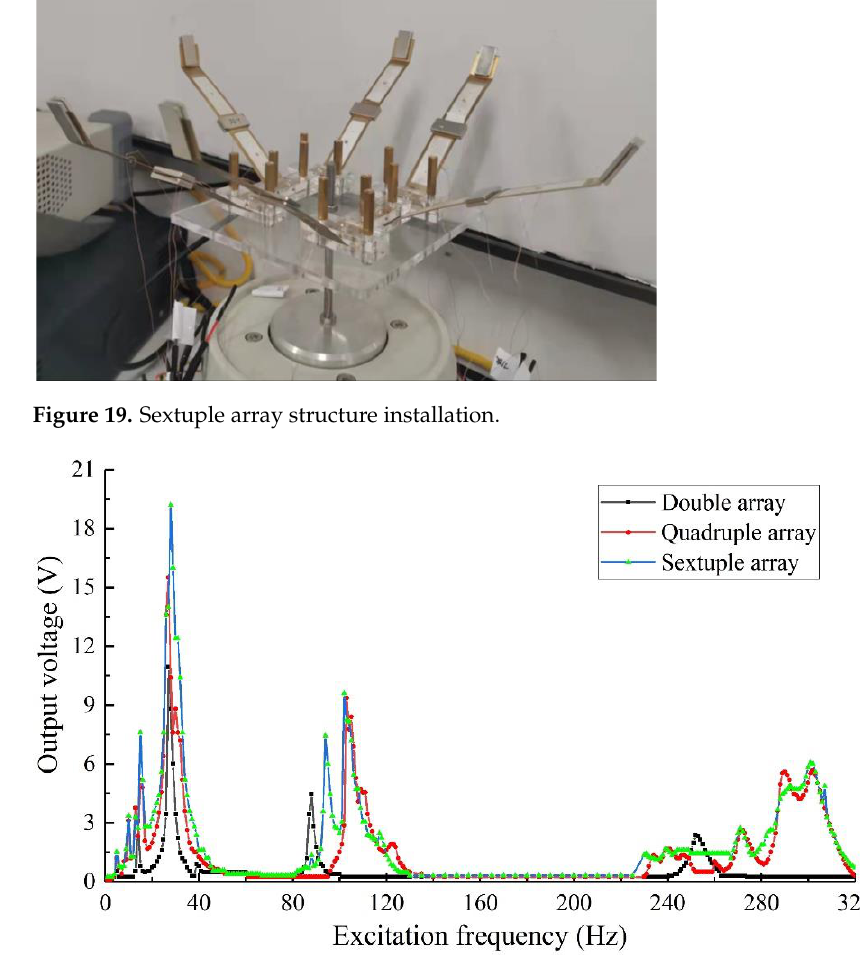
Figure 20. Output voltage of array structure.